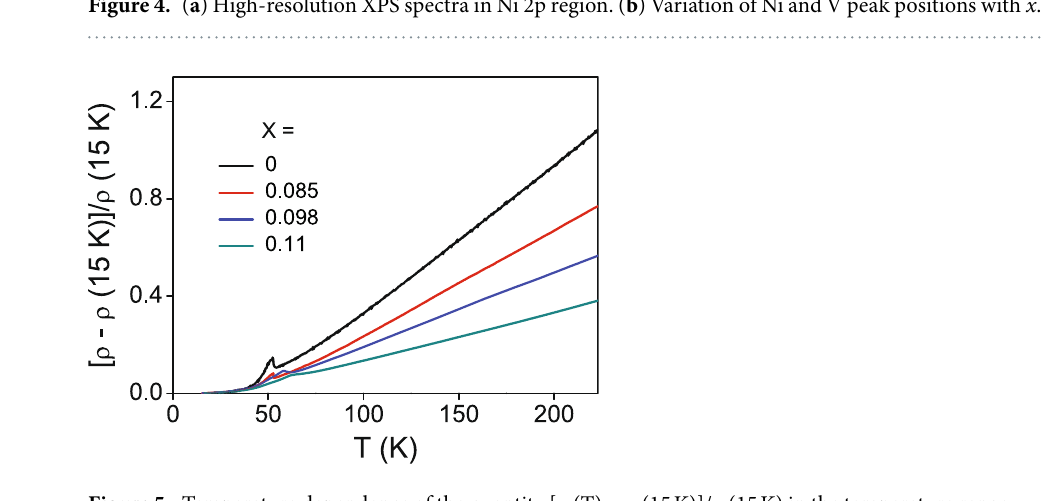
6 Scientific RepoRts | 7: 1223 | DOI:10.1038/s41598-017-01423-x